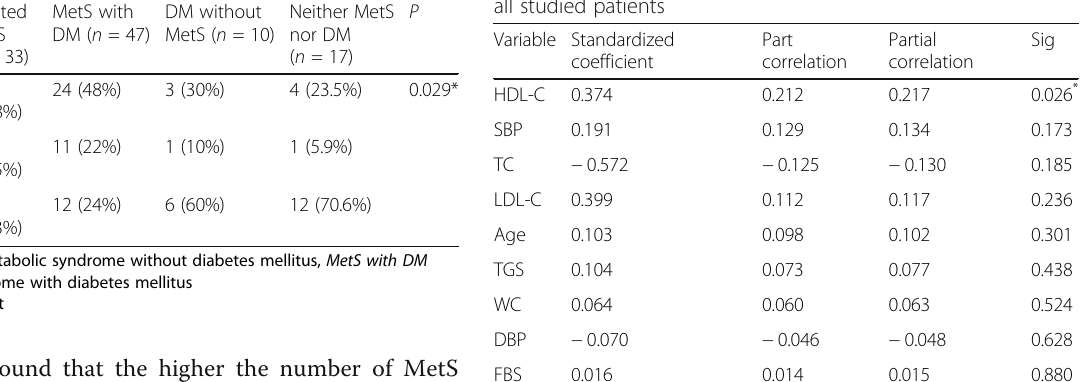
Part Partial correlation correlation